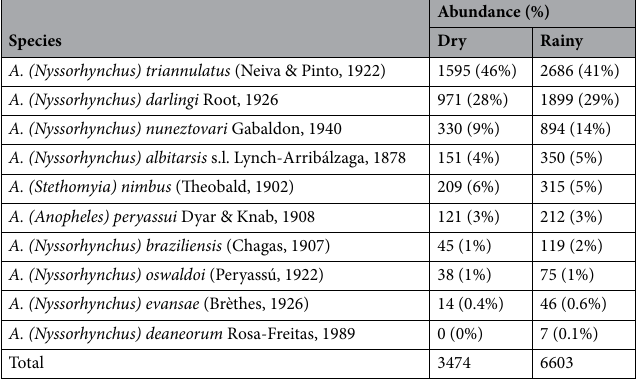
Table 1. Seasonal abundance distribution of Anopheles larvae in 25 larval habitats in the Manaus periurban area.